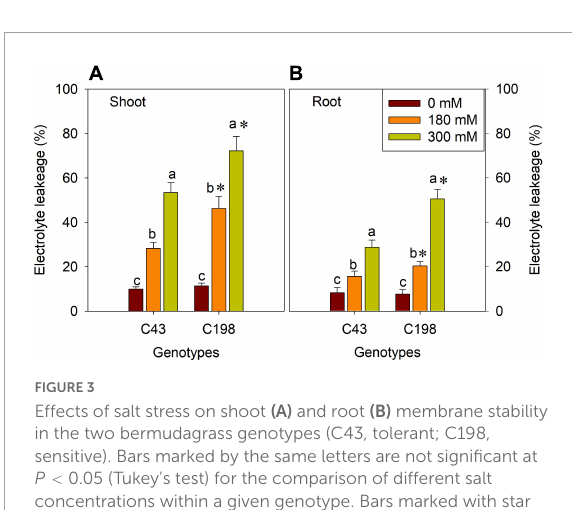
( Figure 8A ). Contrastingly, the expression levels of IPT and CYP735A were increased in the leaves of ‘C43’ but decreased in ‘C198’ after salt stress ( Figure 8A ). Salt stress increased the expression level of CKX only in the leaves of ‘C198’